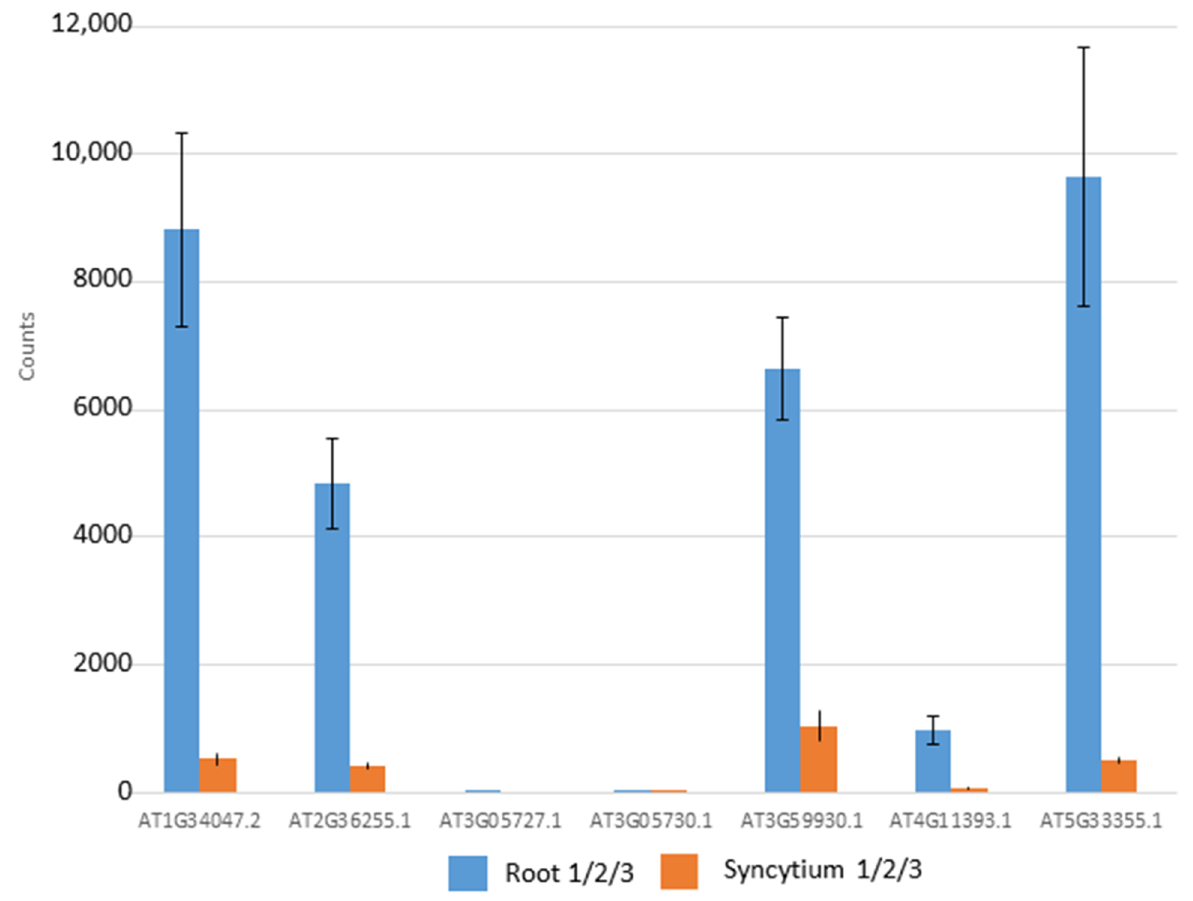
Figure 1. Expression of CRP0770 genes in roots and syncytia. The data shown are TPM (transcript per million) mean values from 3 RNAseq experiments each for roots and syncytia induced by the beet cyst nematode H. schachtii . The error bar represents standard deviation of the mean.